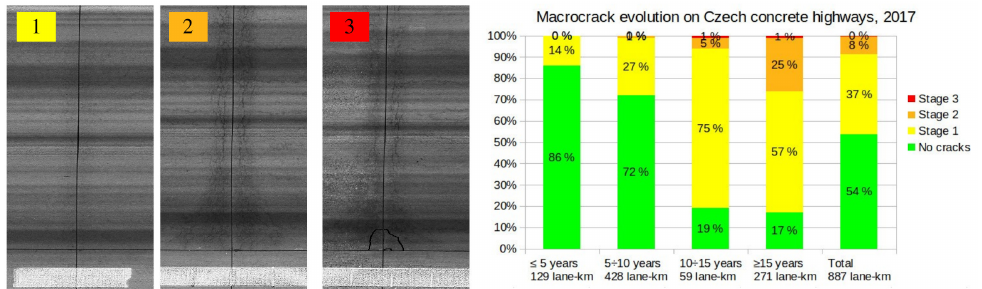
Figure 2. Surface cracking of Czech concrete pavements built mostly after 1990 [15].